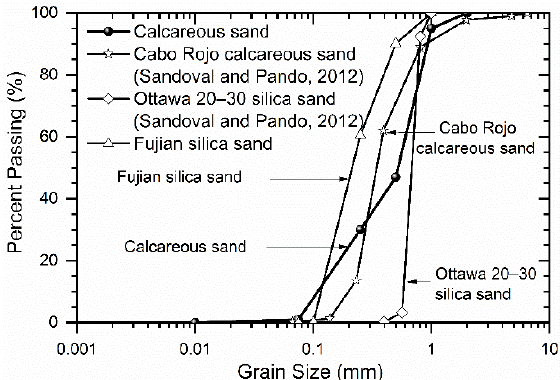
Figure 3. Particle size distribution of the calcareous sand and other calcareous and siliceous sands. Table 1. Properties of the calcareous sand and other calcareous and siliceous sands.